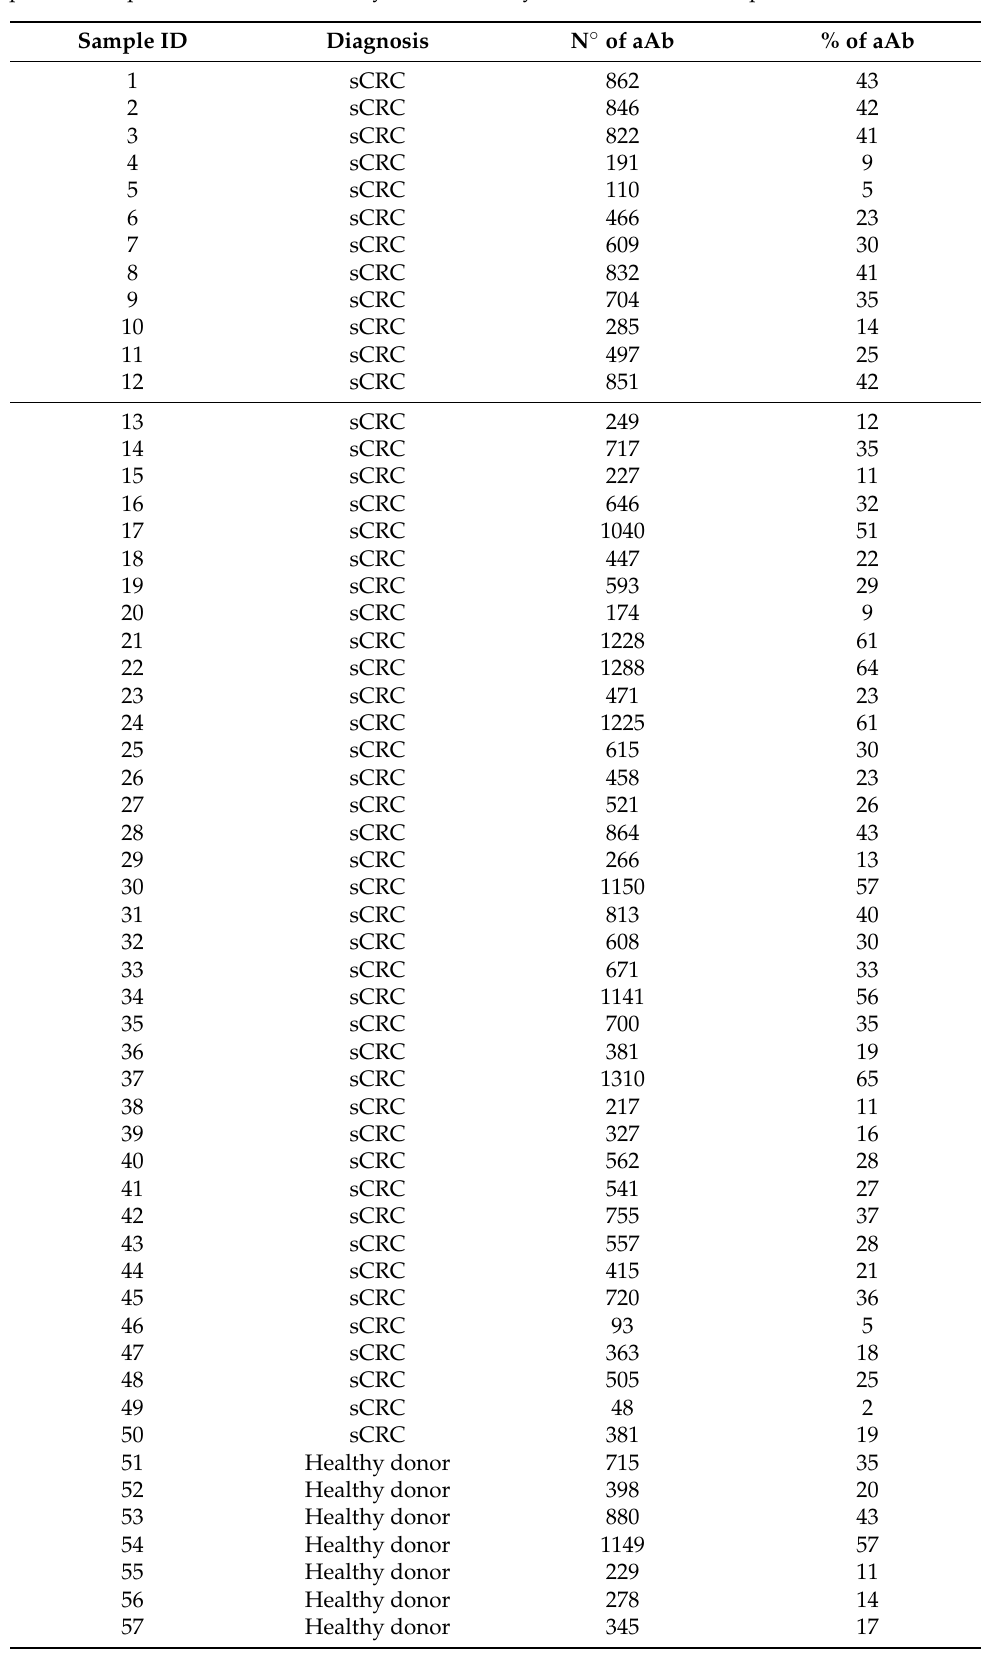
Table 2. aAb against unique TAA proteins ( n = 2023) included in the NAPPArray identified in each plasma samples included in the study from 7 healthy donors and 50 sCRC